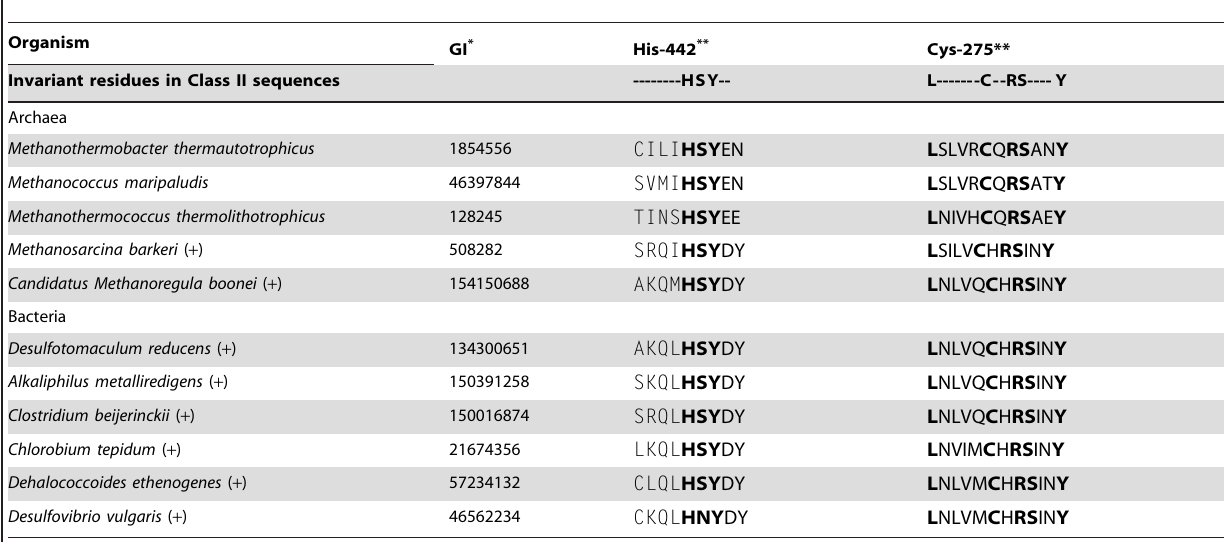
Table 2. Group II NifD sequences surrounding the His and Cys residues that attach the MoFe cofactor to the protein.